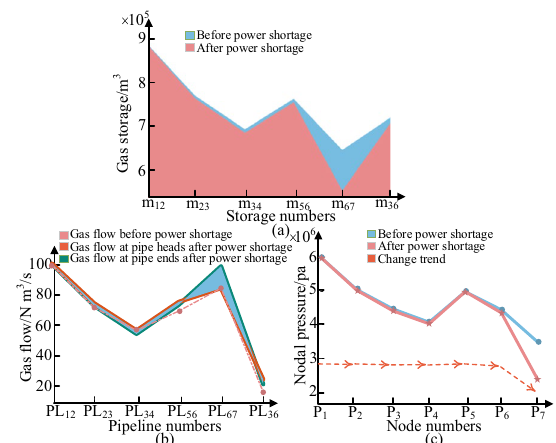
Based on the 8-node gas network structure shown in Fig. 2, the changes of gas pressure, gas flow rate and gas storage in the pipelines of the whole gas network are studied assuming power shortages of 500 kWh / s occurring respectively at L 1 − 3 for 3600 s. The network conditions with the power shortages at L 1 − 3 are shown in Figs. 7, 8 and 9, respectively. Figures 7a and 8a dem- onstrate the consumptions of gas storage in each pipe, while Figs. 7b and 8b demonstrate the gas flows in the steady state before power shortages and at pipe heads and ends after power shortages. Figures 7c and 8c dem- onstrate the changes of gas pressure at different nodes and the corresponding change trends of pressure before and after power shortages. The results of power sup- port regarding costs and outputs of power forms are listed in Table 7a–c. Instead of considering the gas network as an entirety and focusing only on input and output flows, the param- eters of each pipeline can vary in a more complex way when taking into account the gas network. Therefore, the power support model considering unified gas-thermal inertia can be established more comprehensively when the variations are considered in detail in the optimization model. From Figs. 7a, 8a and 9a, the increase of load demand at one load group will consume gas storage in almost all the pipelines in the network, especially in the pipelines closest to the power shortage spot. In Figs. 7b, 8b and 9b, the gas flows at pipe heads and ends remain the same in the steady state but deviate after power shortages. Gas inertia output is increased to sup- port power shortages at one load, and this leads to the sudden rise in the gas flow, especially at the end of the pipe where the load group is connected. Therefore, the respective gas flows at the end of the pipes PL 12 , PL 34 , and PL 67 increase more significantly than other flow variations in pipelines when power shortages are at L 1 , L 2 , and L 3 , respectively. The change of flow rate can also reflect the consumption of gas storage by the area between the head and end flows. Gas storage is con- sumed/stored when the flow rate at pipe heads is smaller/ larger than the flow rate at pipe ends. Therefore, the vari- ation trends of the area between the head and end flows in Figs. 7b, 8b and 9b are consistent with the variation trends of the gas storage in Figs. 7a, 8a and 9a. In Figs. 7c, 8c and 9c, the change of pressure is caused by the variation of gas flow. Since the natural gas flowing out of the pipeline is too fast to be replenished in a short time, the rise in the gas flow will lead to a delayed fall in pressure. The pressure drop at the power shortage spot is particularly large given the largest gas storage supply,